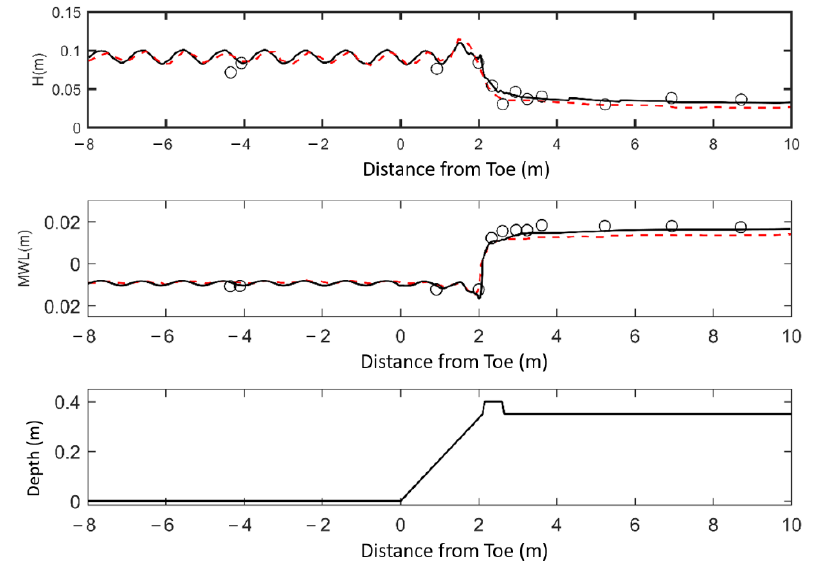
Figure 3. Variation of wave height and mean water level over the reef profile for Case 2. Black solid line: predictions by present model; red dashed line: predictions by Yao; open circles: laboratory measurements.